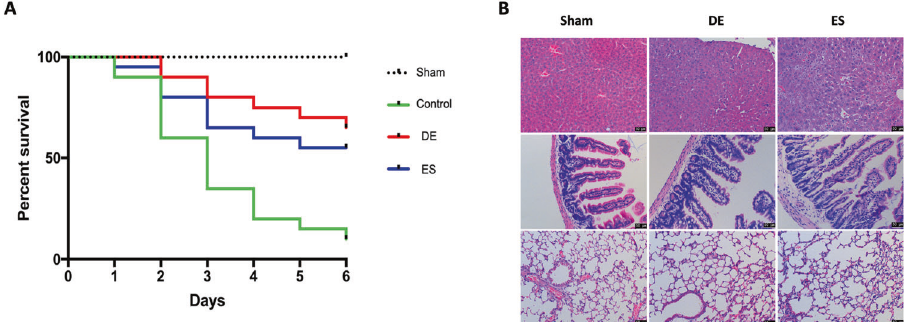
Fig. 1 Survival rates and morphologic changes in liver, intestine, and lung tissues, in late sepsis stage (day #6). A Survival rates of CLP sepsis mice treated with the DE or the ES method comparing with the control group at day 6 after CLP operations. Although there was no signi fi cant difference between the DE and the ES group ( p = 0.051), the DE has the greatest survival bene fi ts compared with other groups. B Mice in sepsis groups showed more leukocyte in fi ltration and hydropic degeneration in liver tissues, in addition, severe in fl ammatory cells in fi ltration and microvilli damages were found in intestine tissues, and more in fl ammatory cells in fi ltration were found in lung tissues. The DE treatment presented alleviated pathological changes than the ES treatment. DE de-escalation. ES escalation. N = 10 per experimental group and N = 5 in sham